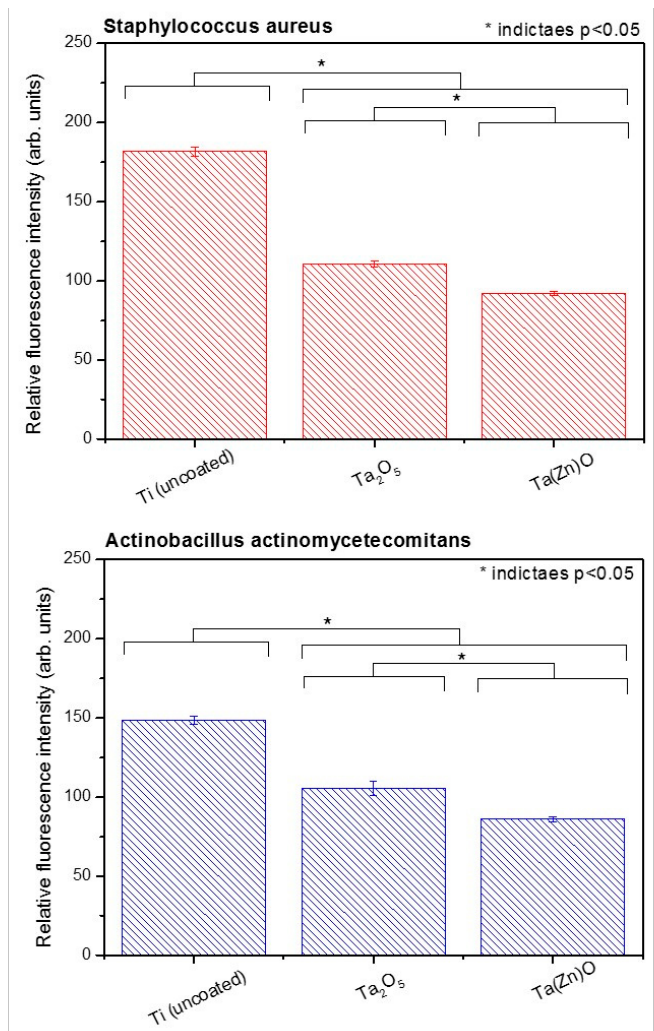
Figure 6. Antibacterial properties of each specimen against S. aureus and A. actinomycetemcomitans. The relative fluorescence intensity represents the bacterial residue with STYO 9 stain, and antibacterial properties among specimens against S. aureus and A. actinomycetemcomitans were different significantly ( p < 0.05). Post-hoc pairwise comparisons were conducted by the Turkey test. The differences were considered significant when p < 0.05.